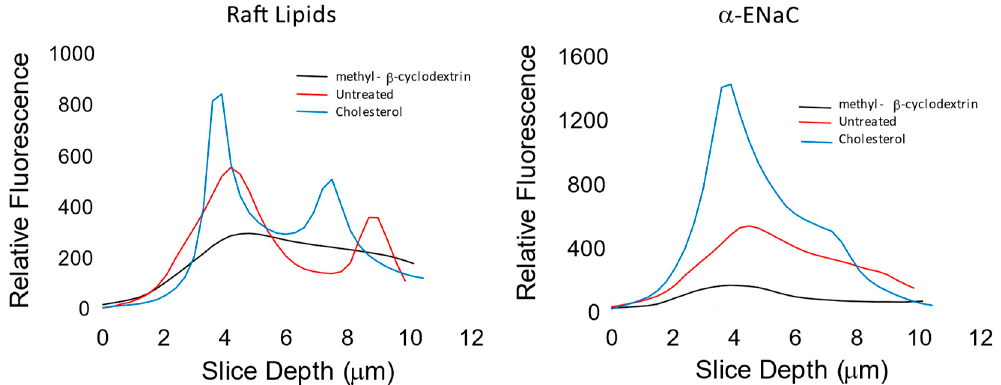
Figure 7. Cholesterol alters the distribution of α -ENaC and raft lipids. We used the z-axis scanning capability of a Leica SP-8MP two-photon microscope to measure the density and relative location with respect to the apical membrane of raft lipids and α -ENaC after no treatment, the addition of exogenous cholesterol, and after 5 min of basolateral M β CD (20 mM) (as in Figure 6). Raft lipids were detected with the cholera toxin B subunit. Slices were made at 0.1 μ M intervals. There are raft lipids in both apical and basolateral membranes, but more lipids in the apical membrane than in the basolateral membrane. After exogenous cholesterol (30 μ M/mL), raft lipids increase above those in untreated cells; and decrease after M β CD. α -ENaC follows the same pattern at the apical membrane; we speculate that the different height of the cells likely has to do with changes in sodium transport activity associated with changes in functional ENaC.